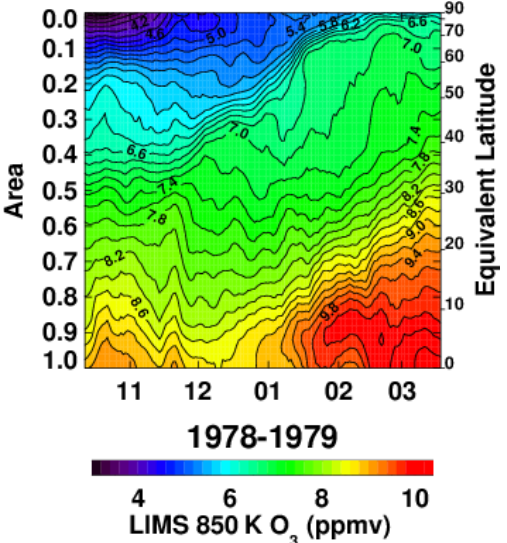
Figure 17. Area diagnostic plot of V6 level 3 ozone for comparison with Fig. 16. Ozone contour interval is 0.2ppmv. Tick marks on the abscissa indicate the 15th day of each month.